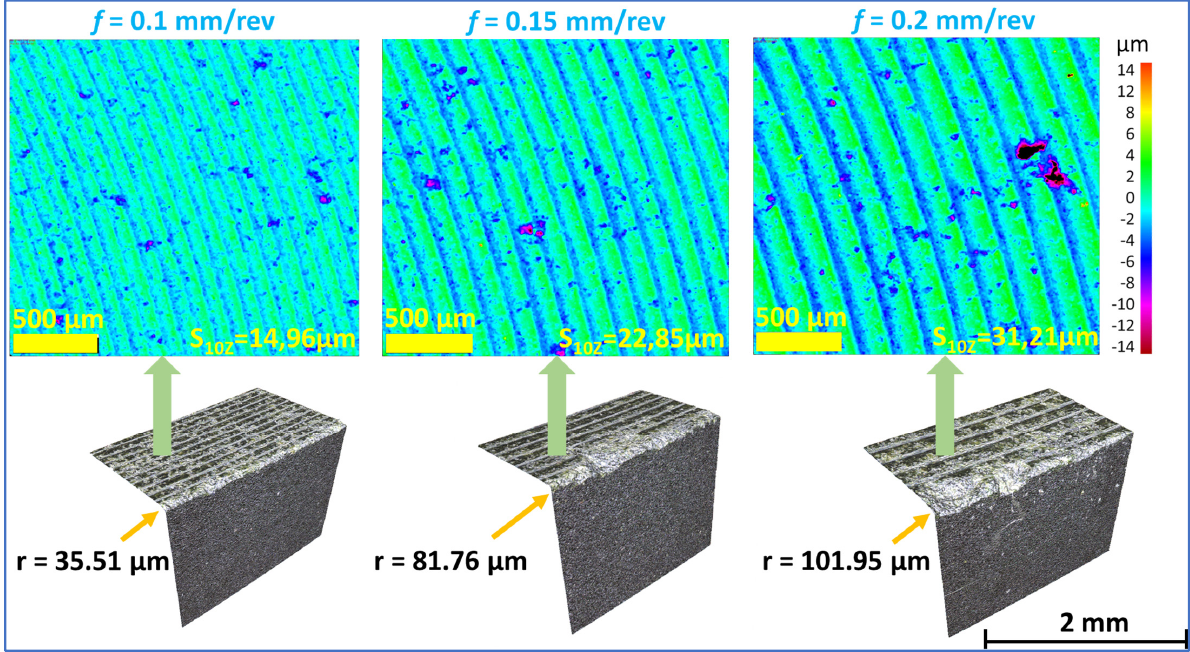
Figure 14. The surface roughness profile analyzed for the bottom section i.e., side 2 of the ceramic. The edge profile for the bottom part was also analyzed to develop a relationship with the surface roughness and the edge profilograms for the varying feed rates are shown in Figure 15. It can be clearly seen that the average profile roughness R a , R q and R z of the bottom part was higher than the top side and these values increased simultaneously with the upsurging feed velocities. The average R z roughness values of the top side at 4.57 µm for 0.2 mm/rev was still marginally lower than that of the bottom part at 5.01 µm for the 0.1 mm/rev setup. The highest obtained R z = 7.78 µm for 0.2 mm/rev on the bottom side was approximately two-folds higher than the top side and this trend in the roughness profiles was similar for the R a, and R q values as well. The z-axis peak height and the cutting width separation in the 0.2 mm/rev turning setup as shown in Figure 15 implies that the higher material removal rate was more detrimental than beneficial for the turning optimi- zation and led to a rougher surface over the slower feed rate options.